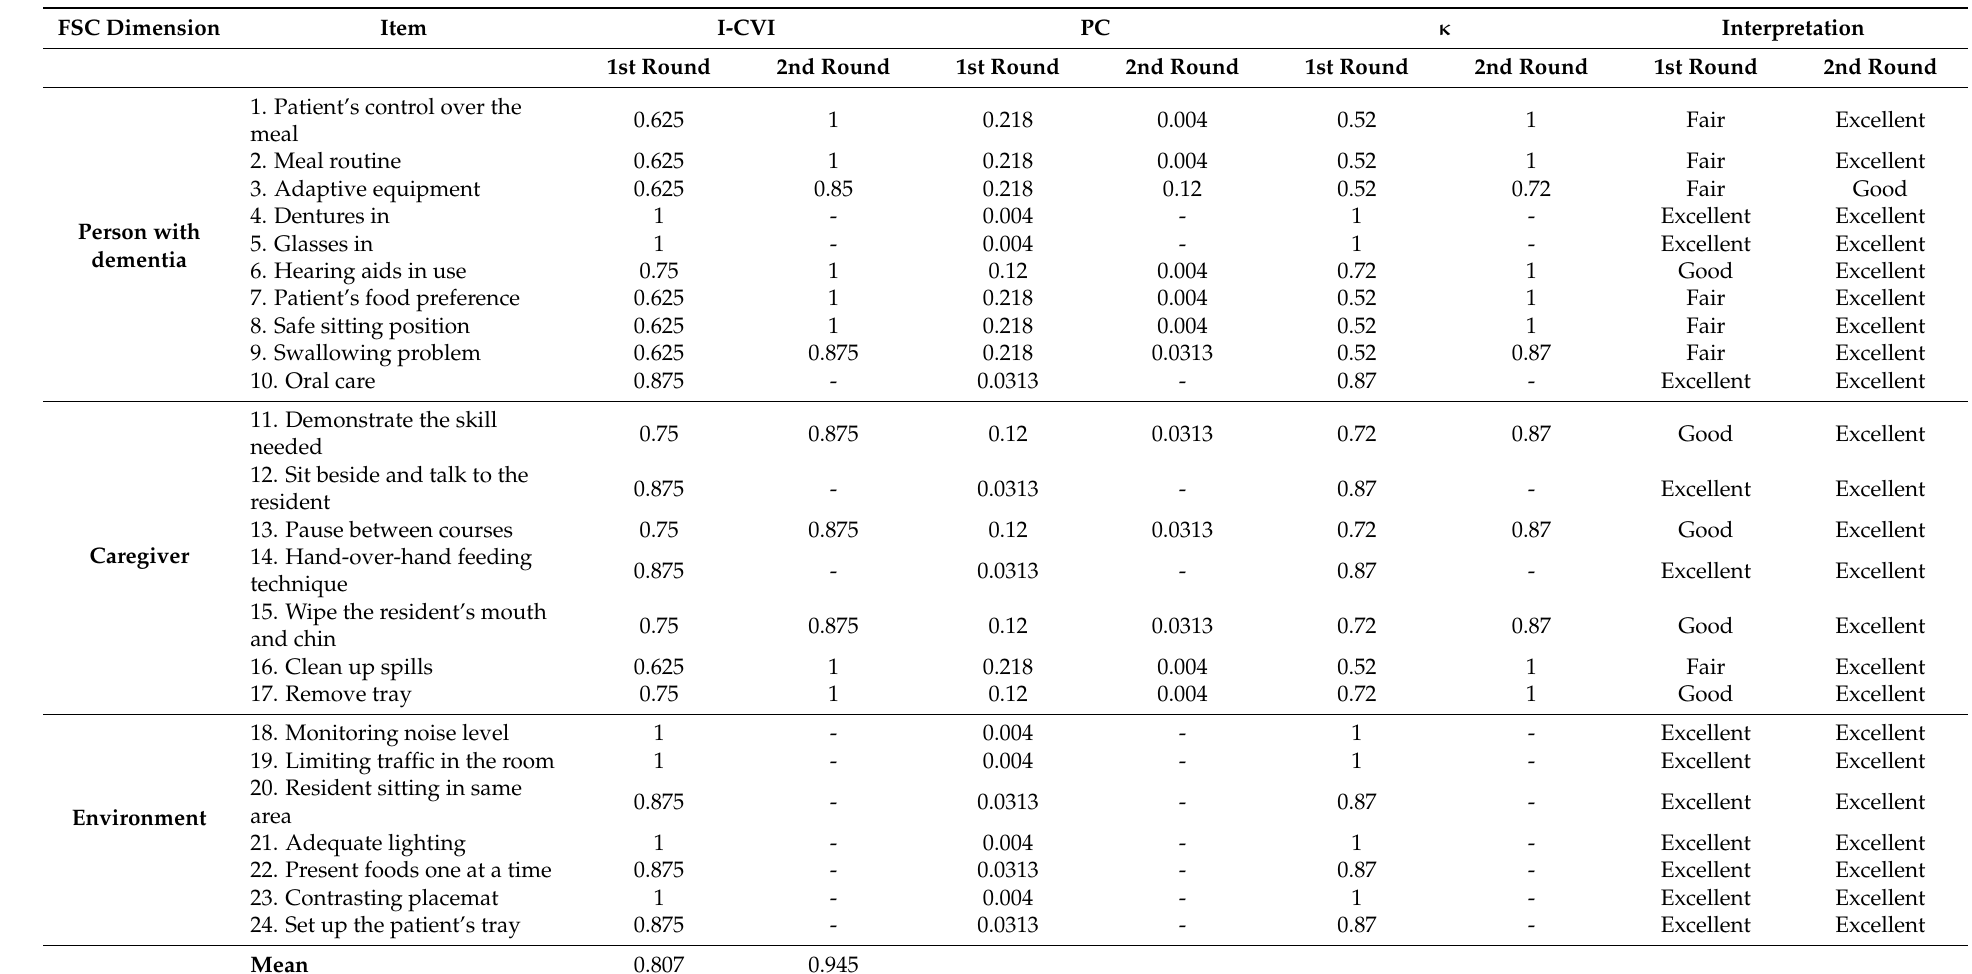
Table 1. Analysis of FSC-PT content